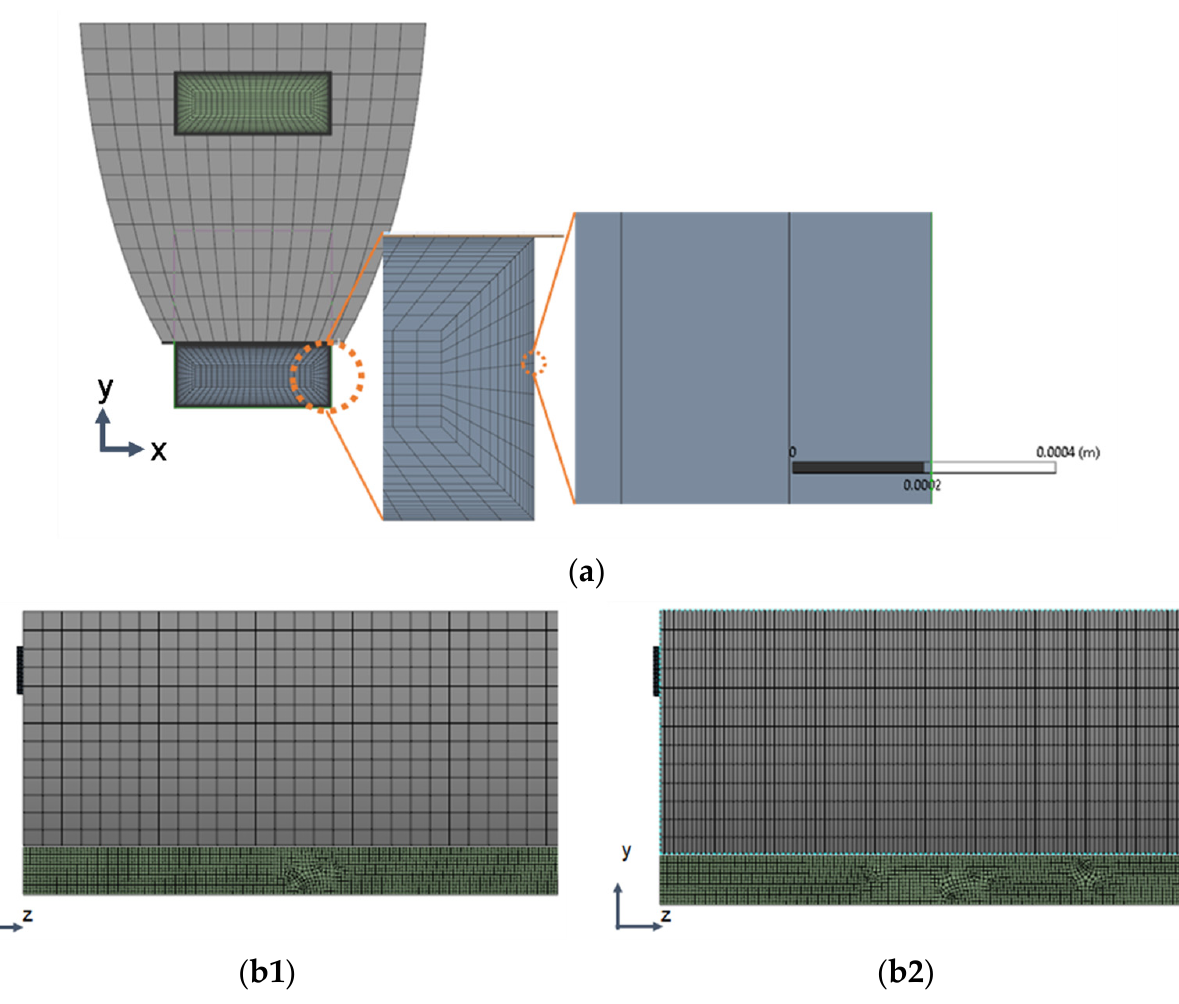
Figure 3. Solar collector mesh. ( a ) Transversal section; ( b1 ) coarse mesh in longitudinal section; ( b2 ) refined mesh in longitudinal section.